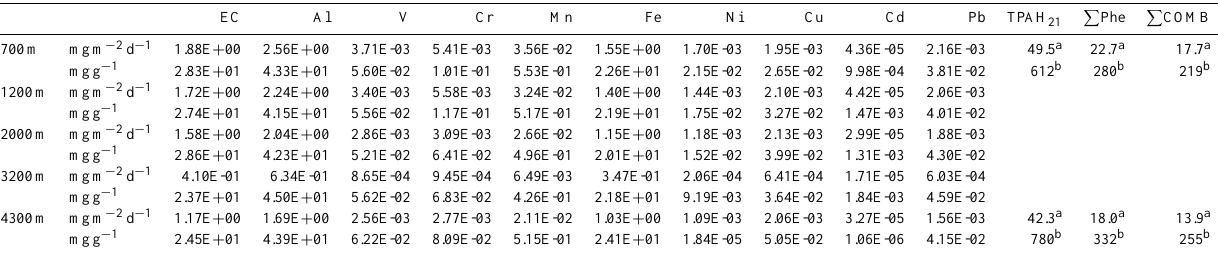
Fig. 1. Location of the sediment trap line deployed in NESTOR basin (SE Ionian Sea, Eastern Mediterranean). The map was produced using Figure 1. Location of the sediment trap line deployed in NESTOR basin (SE. Ionian Sea, Eastern Ocean Data View (Schlitzer, 2011). Table 1. Average fluxes and concentrations of elemental carbon, metals and PAHs measured at sediment traps deployed at 700, 1200, 2000, Mediterranean). The map was produced using Ocean Data View (Schlitzer, 2011). 3200 and 4300m depth.